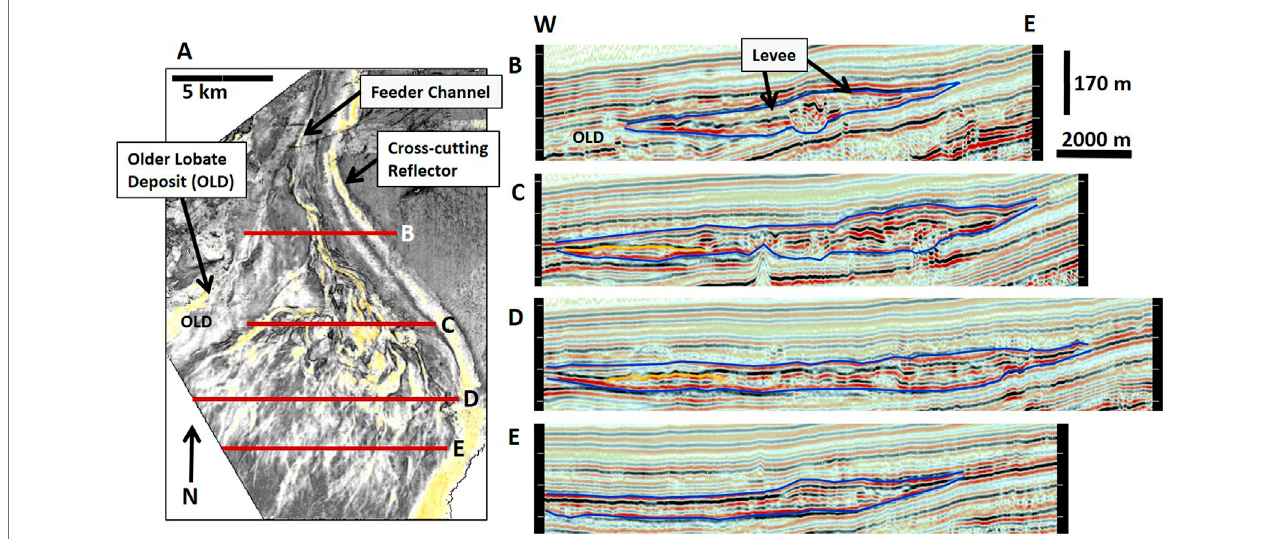
FIGURE 3 | Cross sections through LE1 from a 3D re fl ection seismic volume. (A) Plan view Root Mean Squared (RMS) amplitude extraction midway between the upper and lowerboundingsurfacesofLE1[bluehorizonsinpanels (B – E) ]superimposed onacontinuitydisplay (lateral rateofchangeofRMS amplitude valuesfromthe sameinterval). High RMS values are displayed as white toyellowcolors. Low continuity values are displayed as black. Modi fi ed from Prélat et al.(2010). The locations of cross-sections (B – E) are displayed as red lines. An older lobate deposit (OLD) is present to the west and beneath LE1. (B) Proximal section through the feeder channel complex for LE1. Prominent levees are present on both sides of the channel complex and thin away from the channel complex. (C) Seismic section through the proximal portion of LE1. This portion of the lobate deposit is characterized by highly discontinuous re fl ections resulting from the presence of numerous distributary channels. As an example, the top of a single lens-shaped unit within LE1 is highlighted as a yellow horizon. (D) Seismic section through the medial portion of LE1. This portion of the lobate deposit is characterized by moderately discontinuous re fl ections, resulting from the presence of numerous distributary channels. The top of one lens-shaped unit within LE1 ishighlighted as ayellow horizon. (E) Seismic section through the distal portion ofLE1. This portion ofthe lobate deposit ischaracterized by moderatelycontinuousre fl ections.Verysmalldistributarychannelsappeartobepresentinplanviewbutaretoosmall(shallow)tobreakupre fl ectioncontinuityinsection view. Lens-shaped units within LE1 are not